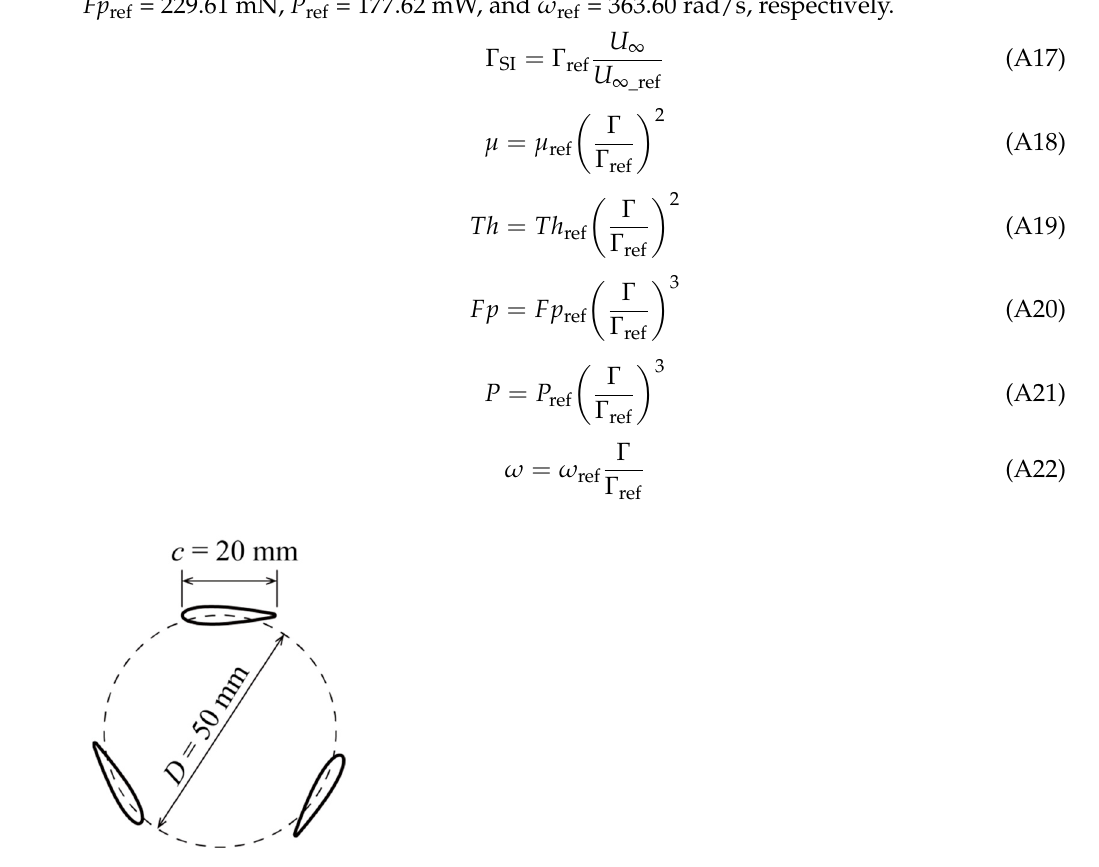
Figure A4. 2D-VAWT rotor as the target of the CFD calculation.